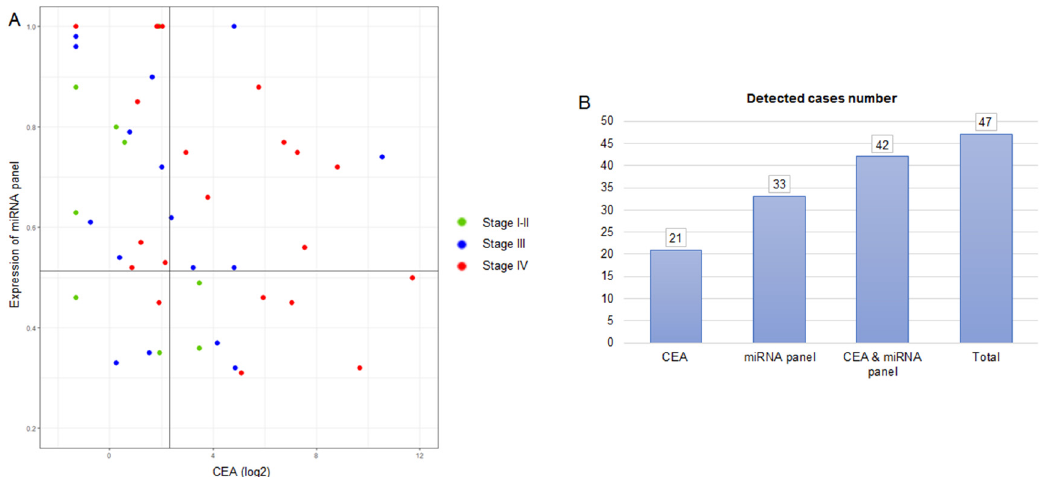
Figure 4. Levels of the five-miRNA panel and serum CEA. ( A ) A combination of the five-miRNA panel and CEA was used to discriminate CRC. The cut-off value for CEA was 5 ng/mL; and the cut-off value for the five-miRNA panel was 0.5132, defined as the model value that provides the highest sensitivity and specificity to discriminate CRC patients from healthy controls. ( B ) Detected cases number using the five-miRNA signature, CEA and their combination. Note: CEA, carcinoembryonic antigen ; CRC, colorectal cancer.